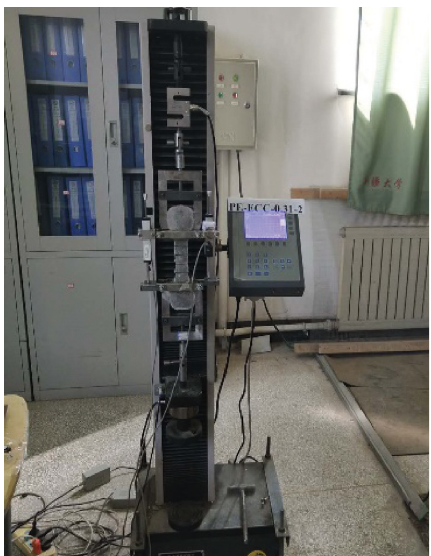
Figure 2: Details of the test